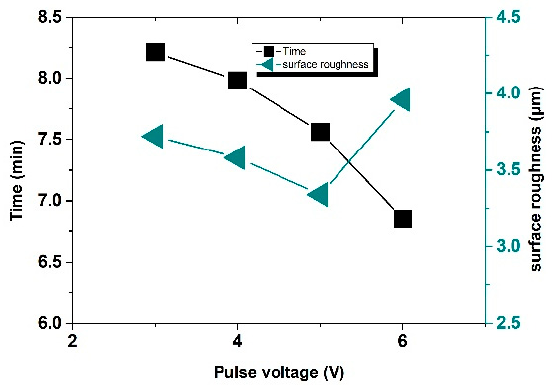
Figure 10. Roughness and machining time of different specimens under different voltages.